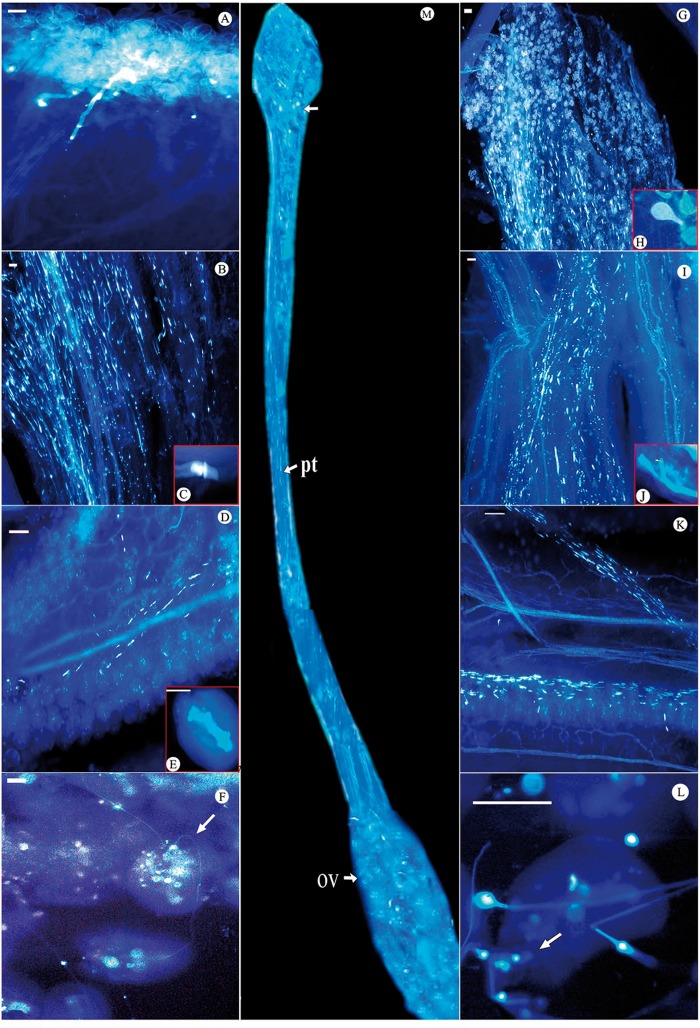
Fluorescence micrographs of self- and cross-pollinated pistils showing pollen–tube pathway. Pollen grain germination on the self- (A) and cross-pollinated (G) stigmatic surfaces and an enlarged portion thereof (H); in the mid-style (B and I) with brightly fluorescing callose plugs (C). Note the arrested growth at the base of the style in self-pollinated pistil (J) with arrow pointing towards the swollen pollen-tube tip. Pollen tubes enter the ovarian locule (D and K) containing cross-pollinated ovules with well formed embryo sac 43 h after pollination (E). Note the pollen–tube entering the micropyle (arrow) and penetrating ovules (F and L). (Scale Bar = 100 µm). (M) Fluorescence micrograph of reconstructed, cross-pollinated pistil of K. pinnata showing pollen tube pathway towards ovary.